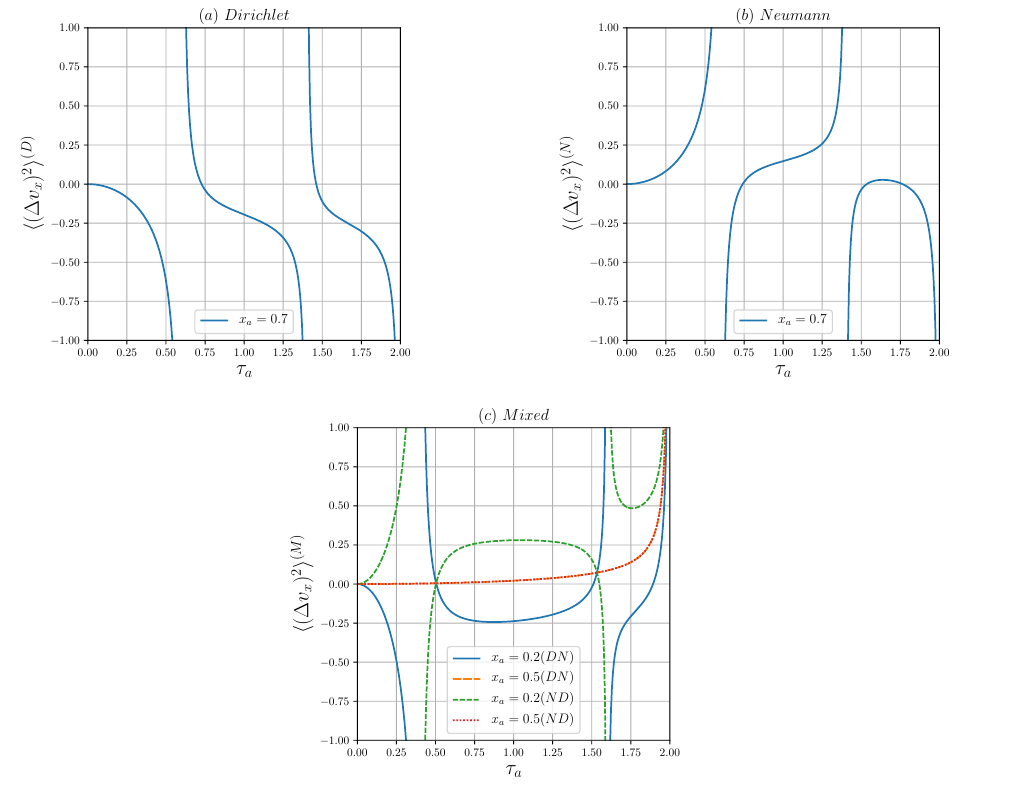
Figure 3 . Graph behavior of the perpendicular velocity dispersion for (a) Dirichlet (D), (b) Neumann (N) and (c) mixed (DN, ND) boundary conditions. Here we have considered the curves in units of h (∆ v x ) 2 i (i) = h (∆ v x ) 2 i (i) ren